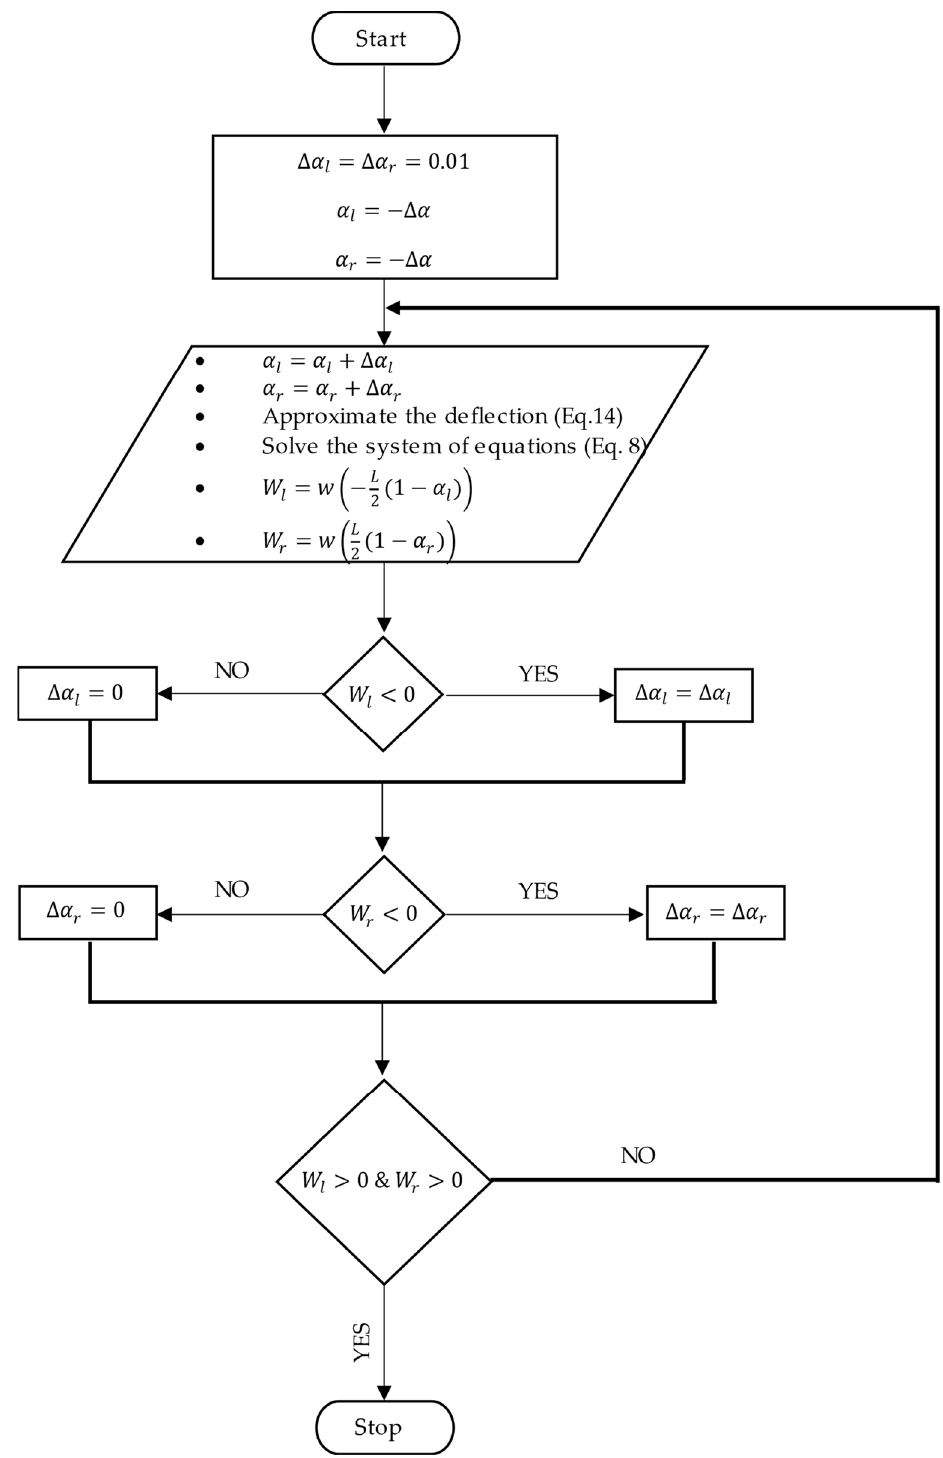
Figure 4. Flow chart on solving an asymmetric free–free beam on tensionless foundation .